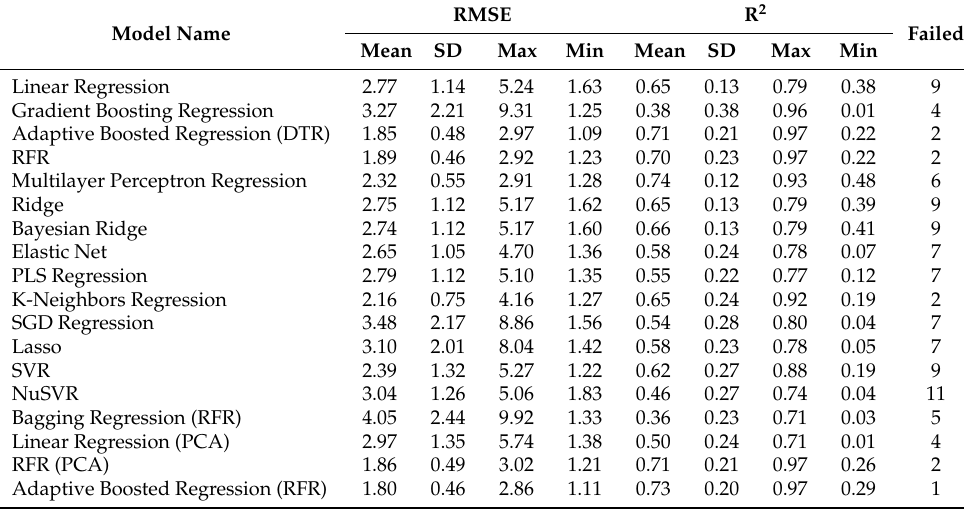
Table A2. RMSE and R 2 values for all models tested on internal\slash external rotation. The failed column shows the number of subjects predicted with negative R 2 values from each model. All models were optimized using Bayesian or grid search optimization. Data presented in this work were calculated with the adaptive boosted regression (RFR)